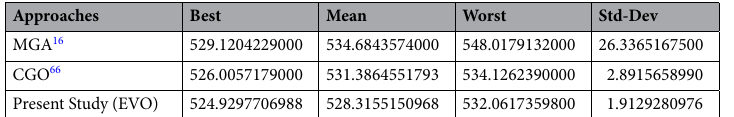
Table 13. Statistical results of the MGA method for the ten-bar truss bearing design problem.